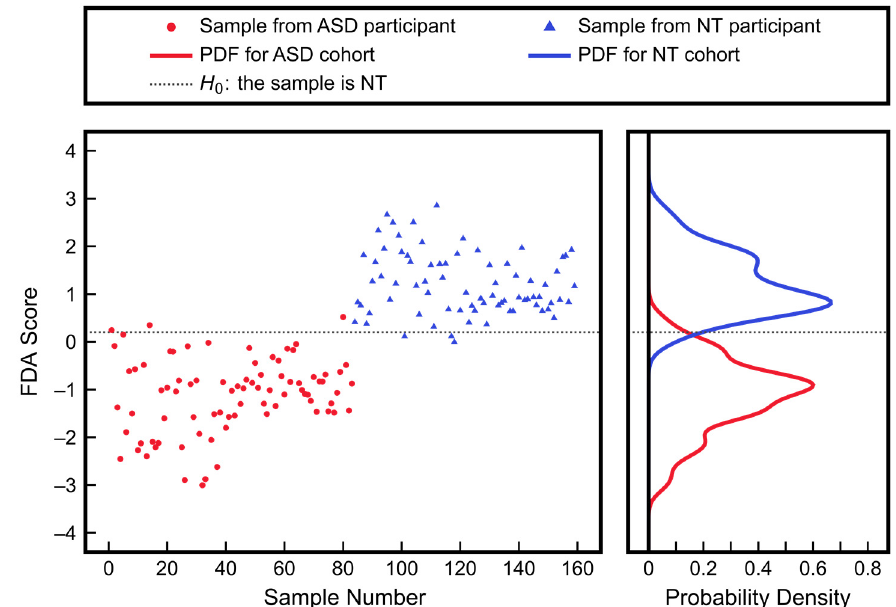
Figure 5. Multivariate analysis with FDA using five measurements from the IMAGE study (% DNA methylation, 8-hydroxyguanosine, glutamylcysteine, free cystine/free cysteine, and % oxidized glutathione). The scores are the projected values obtained by leave-one-out cross-validation with FDA, while the PDFs were obtained by fitting to the scores. The shown threshold corresponds to a Type I error of 4.8% and a Type II error of 5%.